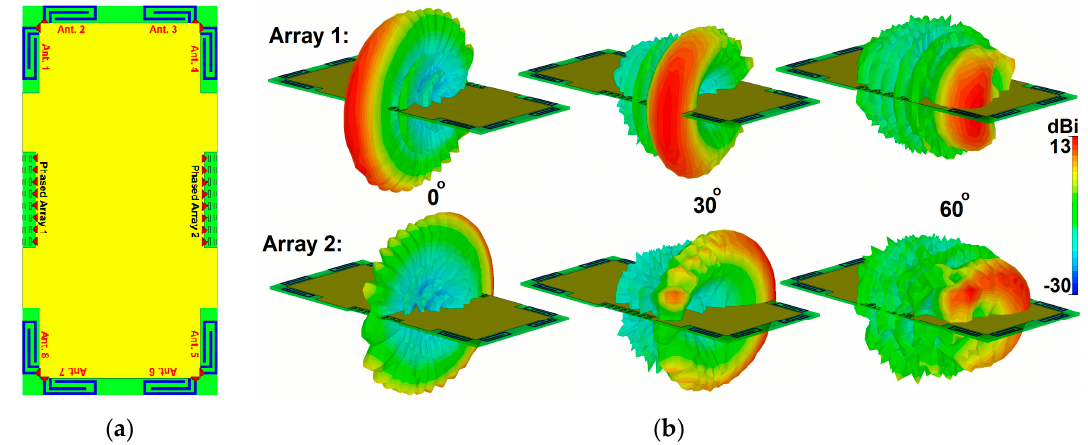
Figure 21. ( a ) Different placements of the proposed phased array into the smartphone board and ( b ) Figure 21. ( a ) Di ff erent placements of the proposed phased array into the smartphone board and its beam steering function at different angles. ( b ) its beam steering function at di ff erent